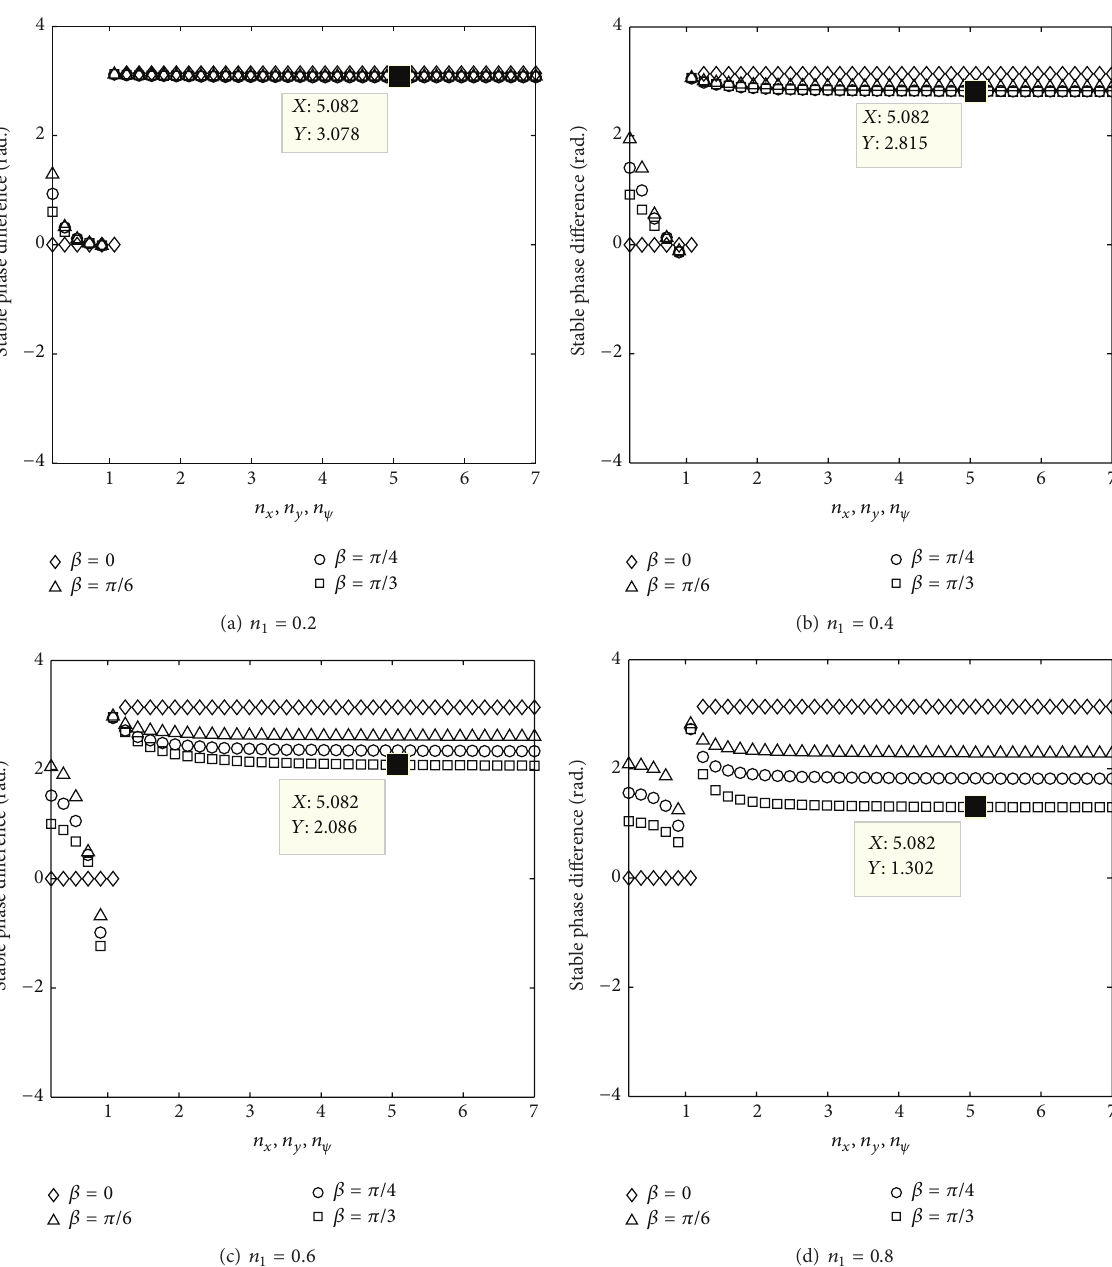
Figure 3: Stable phase difference for SBCWB and SACWB considering variation of frequency ratio 𝑛 1 with 𝜂 13 = 5 , 𝜂 23 = 1 , 𝑟 𝑜 = 2 , 𝑟 𝑙 = 0.08 , and 𝑙 = 0.6 : (a) 𝑛 1 = 0.2 , (b) 𝑛 1 = 0.4 , (c) 𝑛 1 = 0.6 , and (d) 𝑛 1 = 0.8